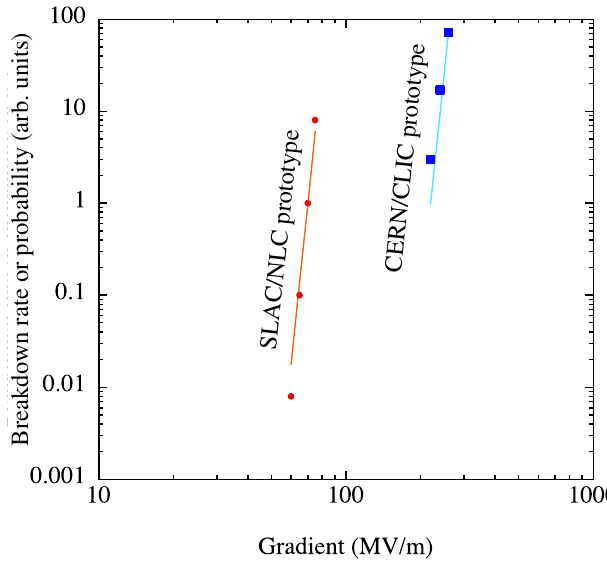
FIG. 12. (Color) Comparing breakdown rates from NLC proto- type cavities, and breakdown probabilities from CERN/CLIC waveguide tests, from Refs. [32,35], compared to the (cid:2) E 25 field dependence expected from this